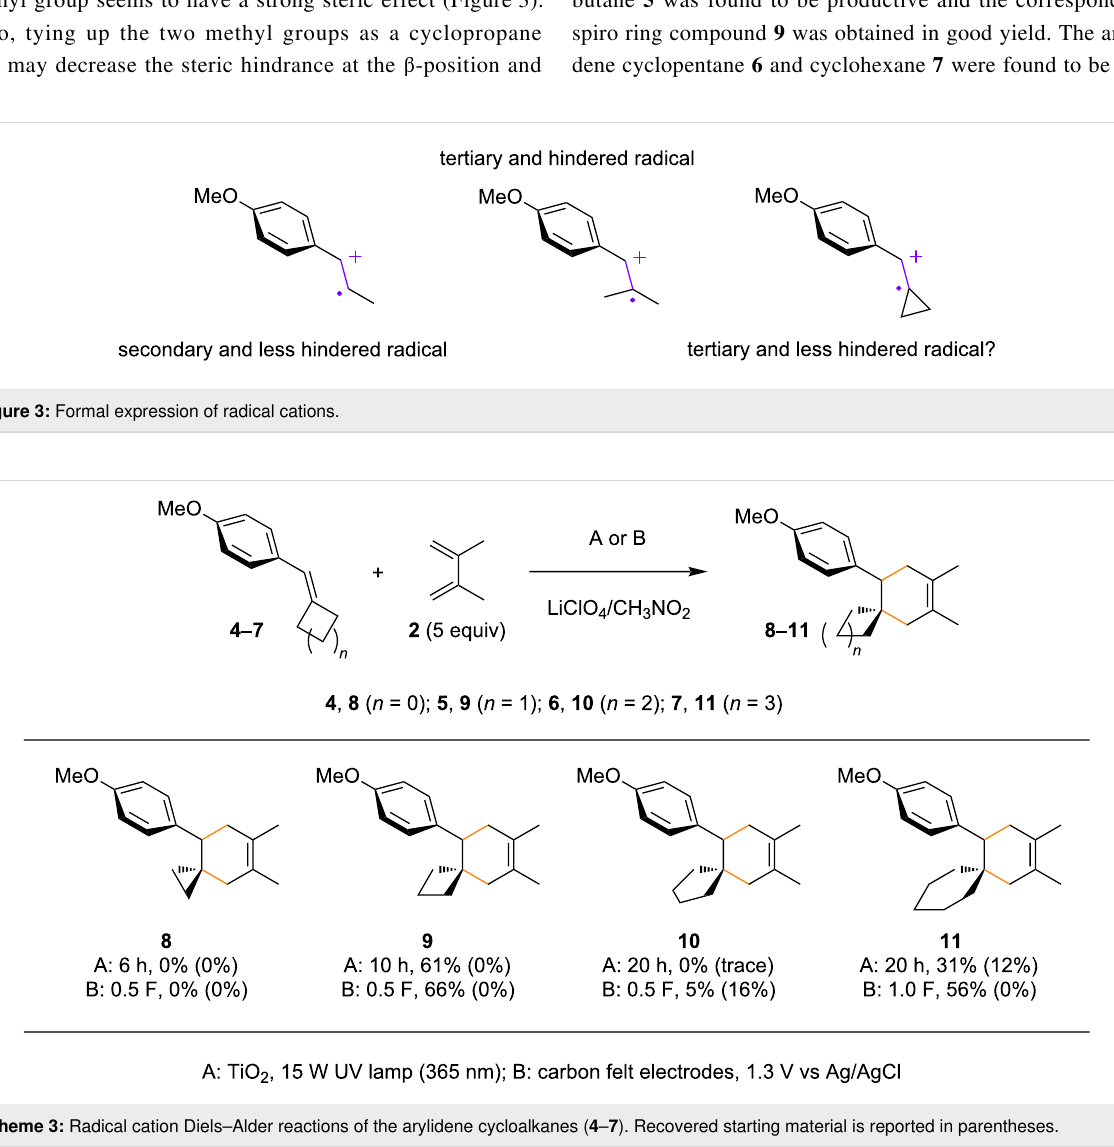
ditional methyl group at the β -position had a significant impact on the reaction. In general, tertiary radicals (or cations)